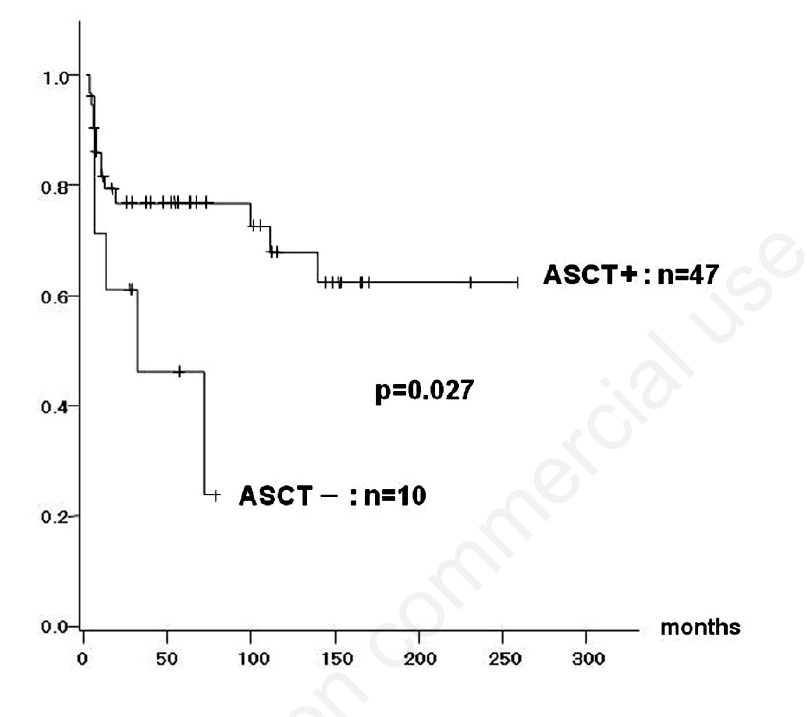
Figure 1. Event free survival of patients with autologous stem cell transplantation (ASCT) compared to those without ASCT. Significant superiority by log-rank test in patients with ASCT is observed (75.8% vs 45%).